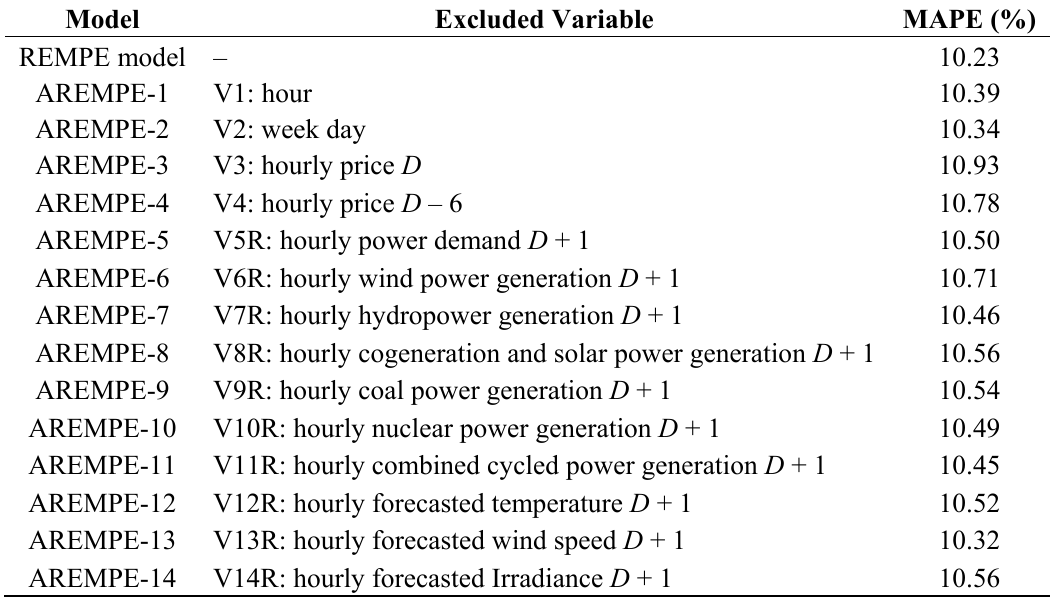
Table 2. Alternative Explanatory Models for Price Estimation and their mean absolute percentage error (MAPE)